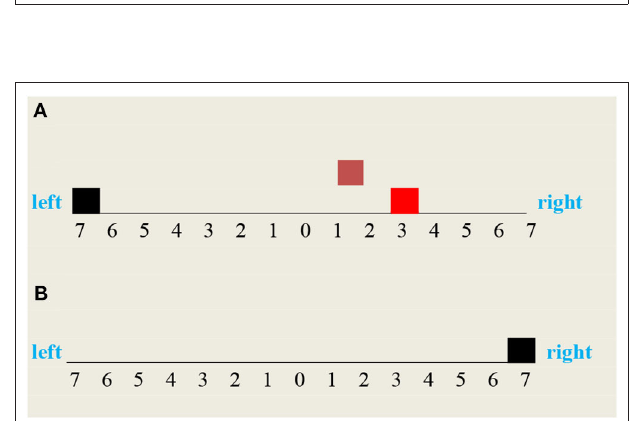
FIGURE 8 | Vehicle two possible moves: (A) the vehicle moved backward to the left and missed the fire , (B) the vehicle moved forward to the right and cleared the